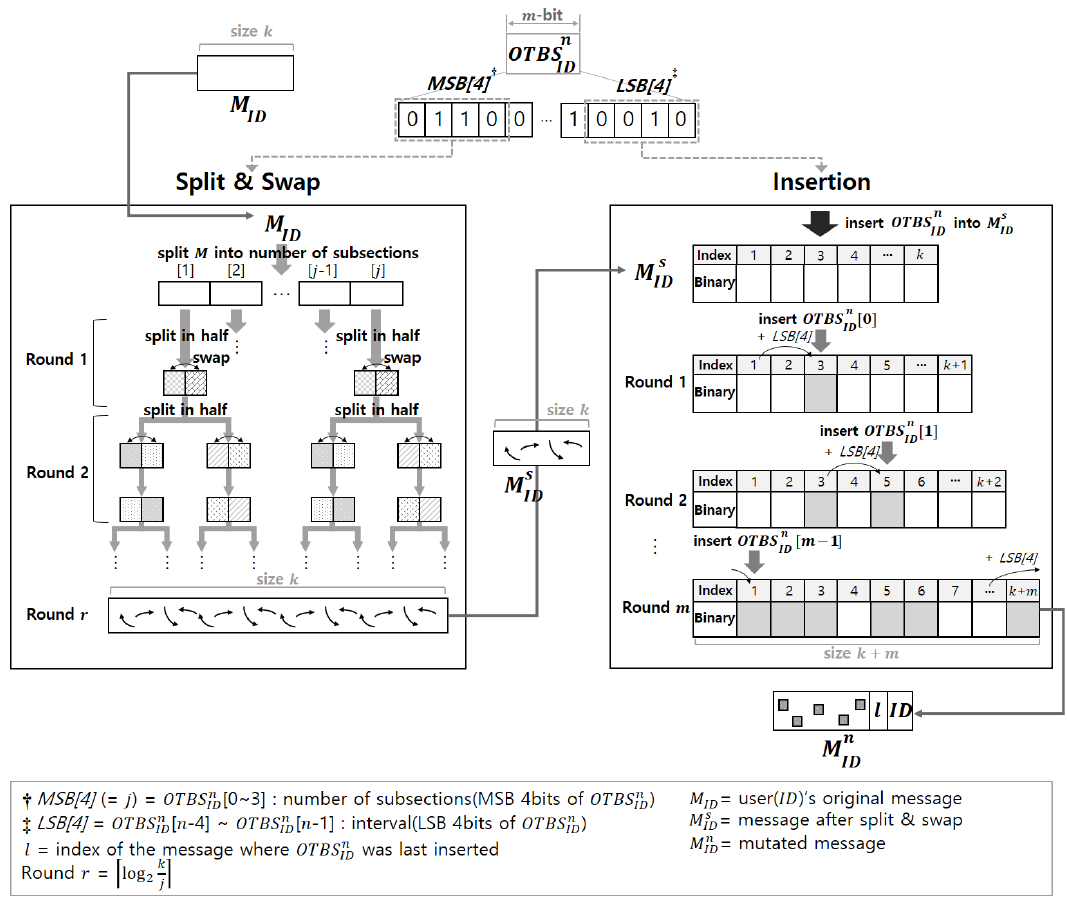
Figure 2. Internal operations overview of protocol